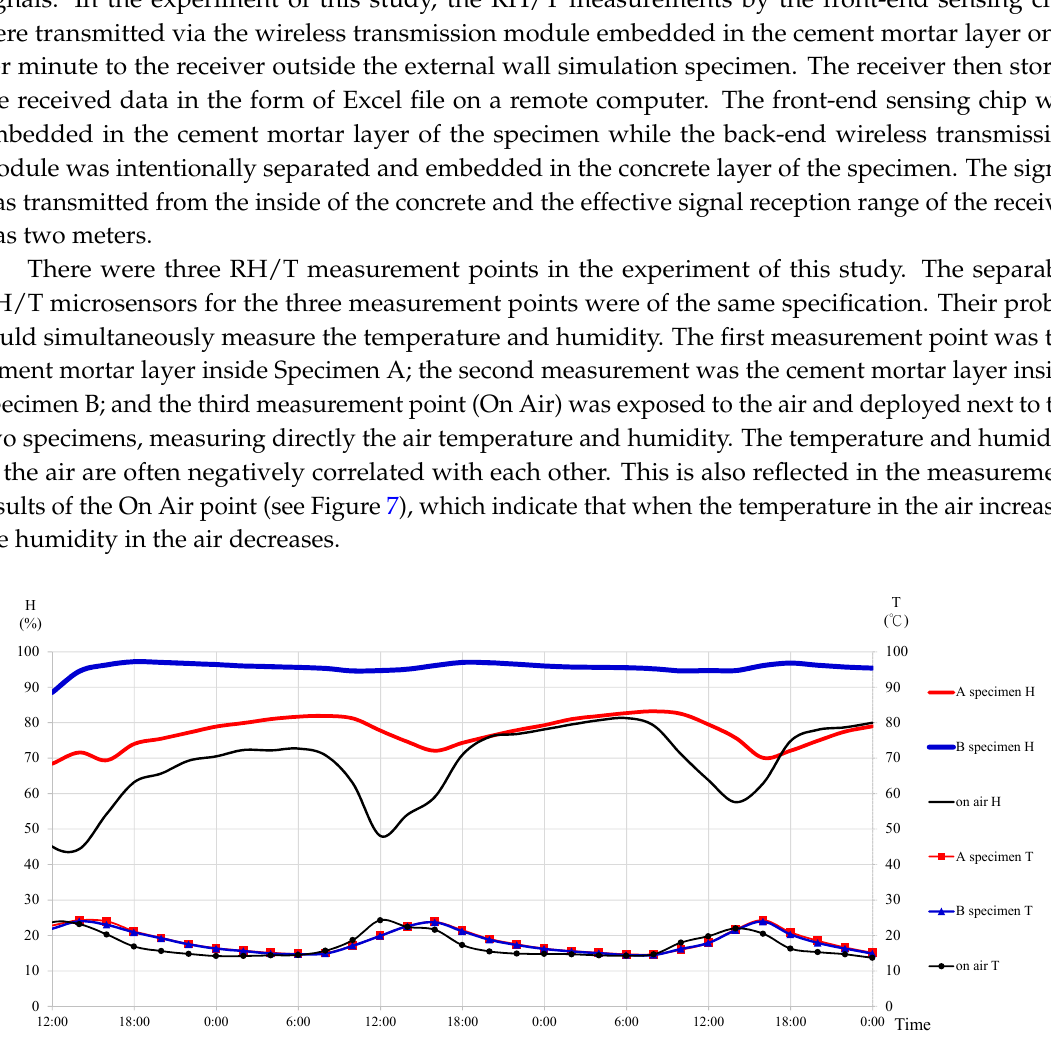
Figure 7. Results of Temperature and Humidity Measurements.